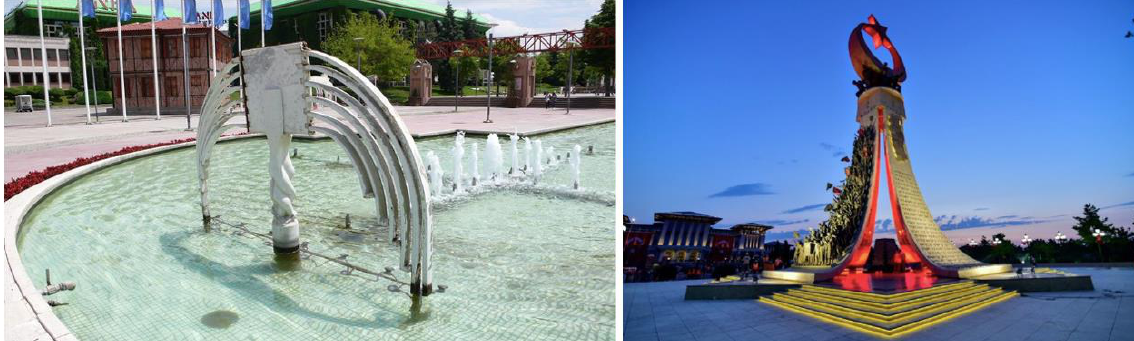
Figure 2 Sculpture as the prevalent type of public art in Turkey: the abstract versus figurative representation as a tool for cultural politics reflected on space. (Source: URL-4,